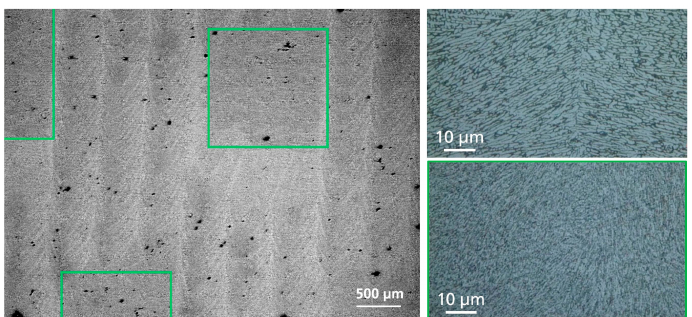
Figure 9. Application of results. Designed Material consisting of coarse- ( top right ) and fine-grained areas ( bottom right marked in